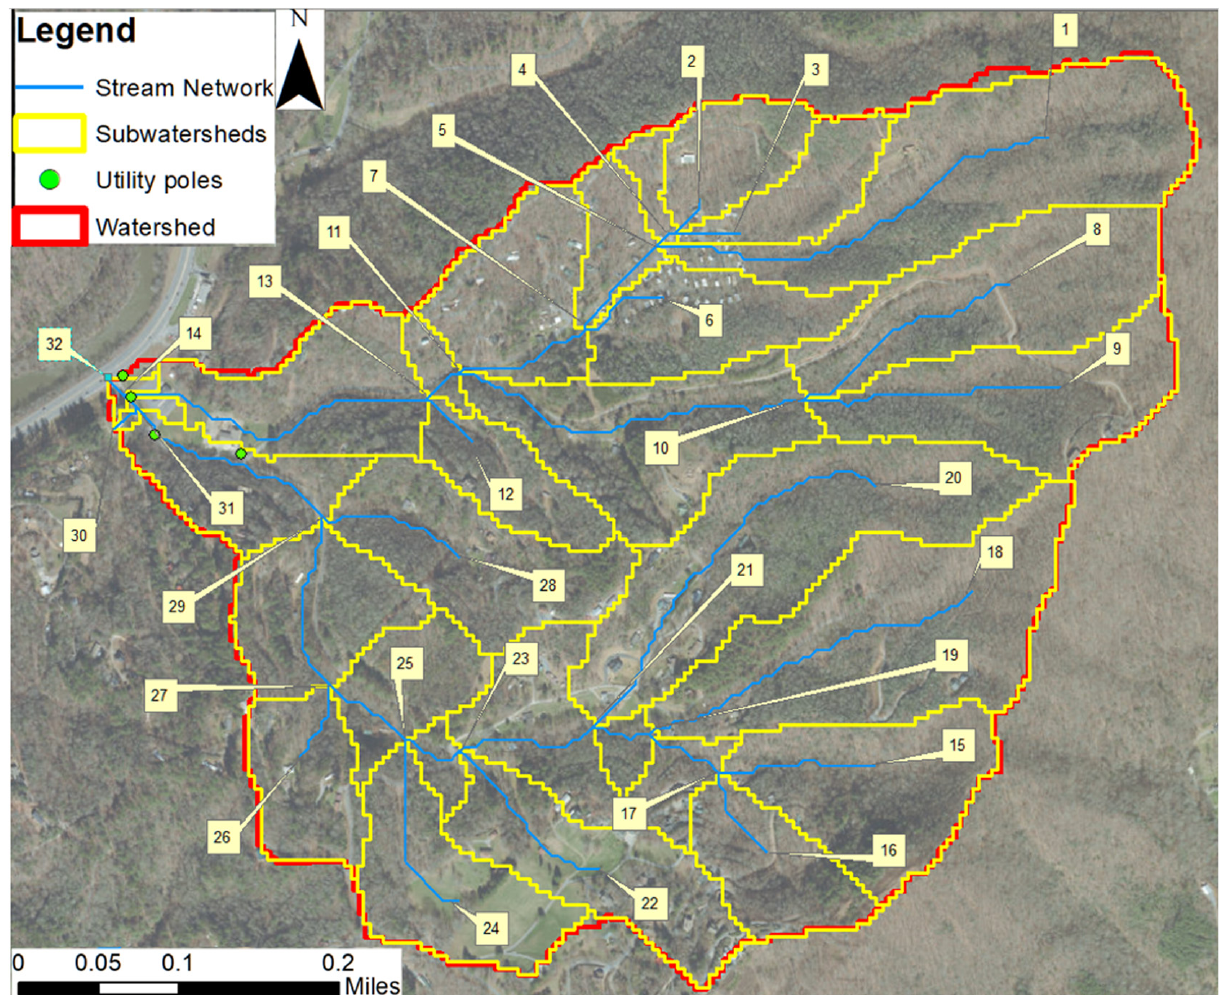
Figure 1. Whittier, NC watershed with labeled nodes shown in yellow square text boxes (35.399467°, − 83.292734°).